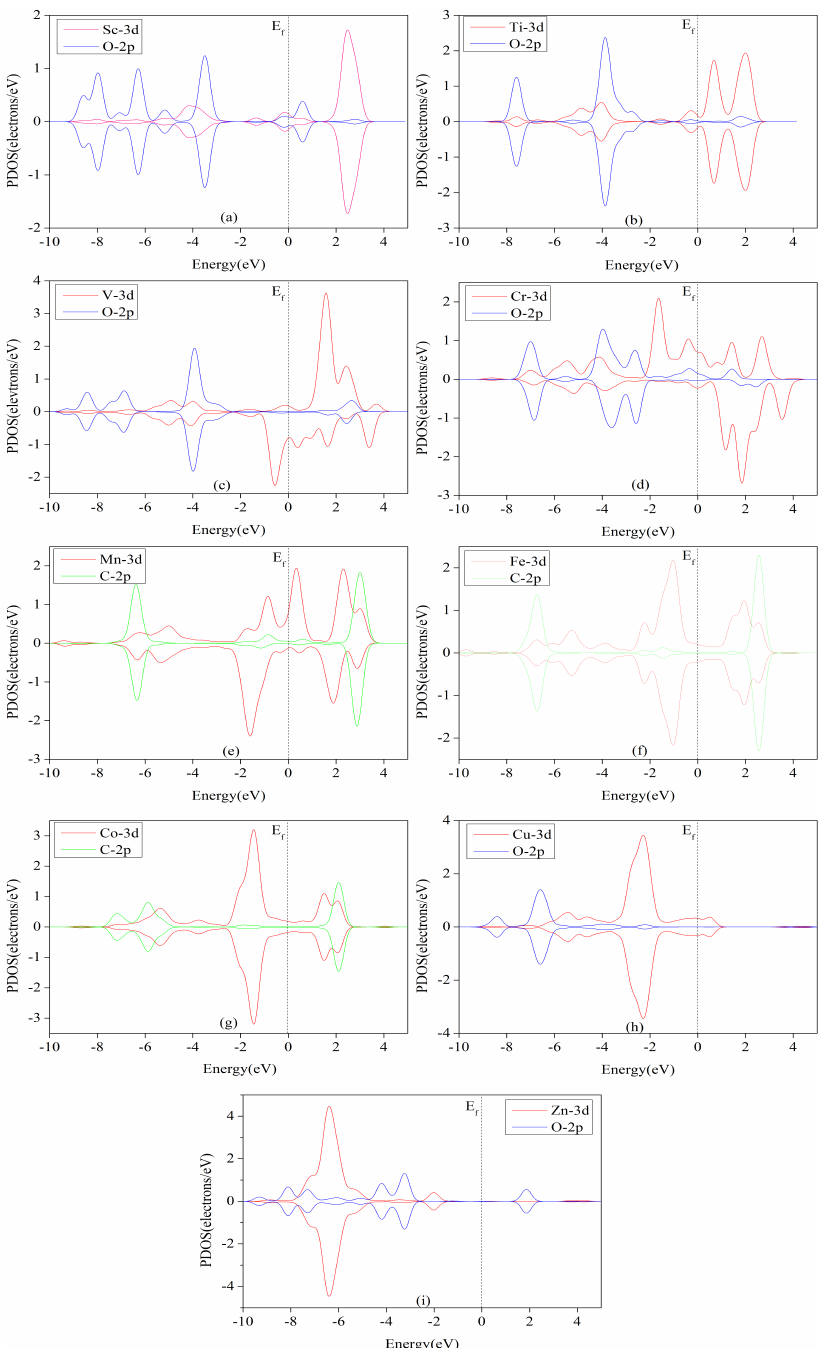
Figure 10. The projected partial density of states of *OCH 2 adsorbed on Sc, *OH adsorbed on Ti and Cr, O*CHOH adsorbed on V and Zn, *CO adsorbed on Mn and Fe, *CHO adsorbed on Co, and *OHCH 3 adsorbed on Cu. The dotted lines denote the Fermi level. The red, green, and blue lines represent the 3d orbital of the metal atoms, the 2p orbital of the oxygen atoms, and the 2p orbital of the carbon atoms,